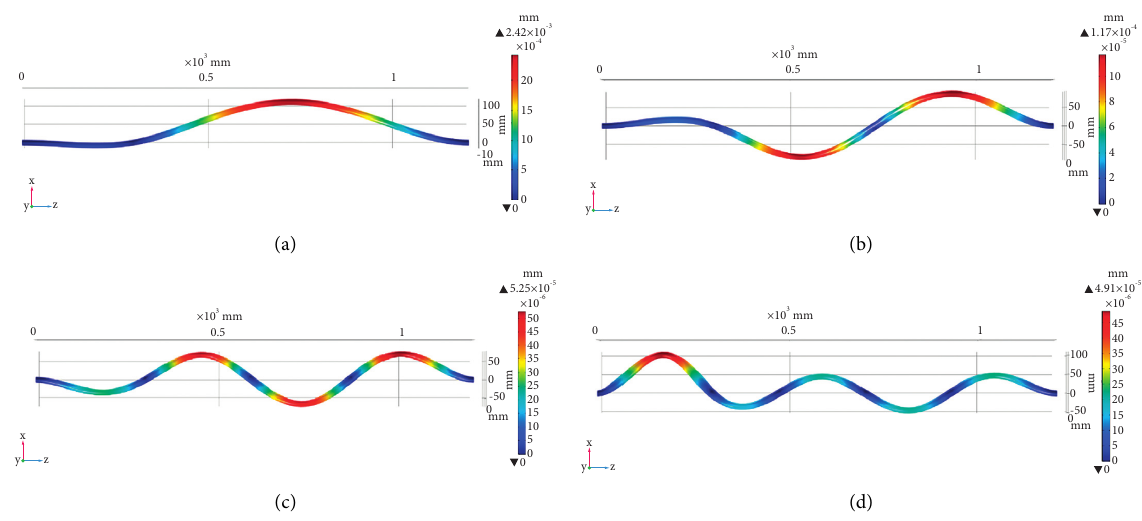
Figure 7: “100” mode. (a) First order. (b) Second order. (c) Third order. (d) Fourth